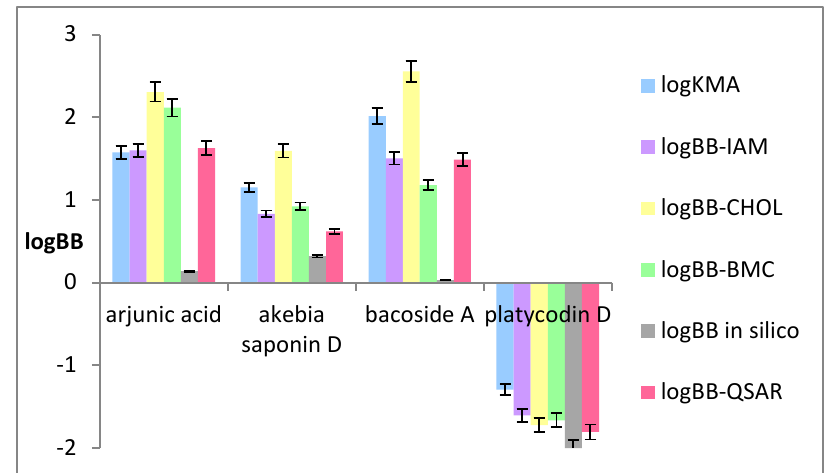
Figure 2. LogBB values obtained using the biomimetic and computational methods.